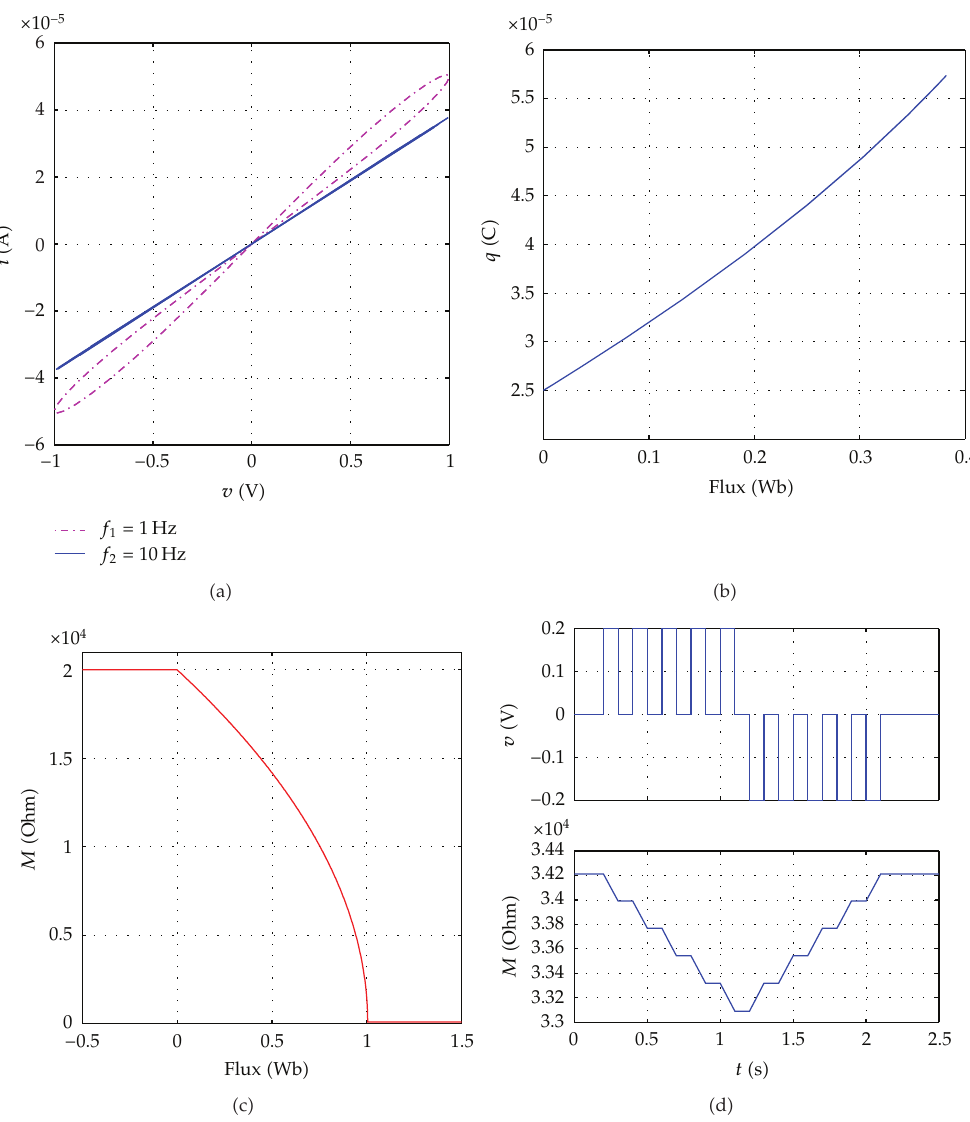
Figure 3: Characteristics of memristor. (cid:3) a (cid:4) Typical memristor i - v pinched-hysteresis loop; (cid:3) b (cid:4) memristor q - φ curve; (cid:3) c (cid:4) memristance versus state map; (cid:3) d (cid:4) memristance changes with a series of voltages pulses.